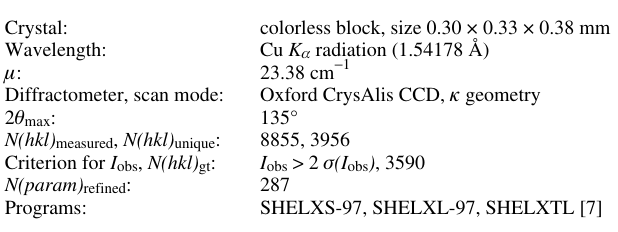
Table 1. Data collection and